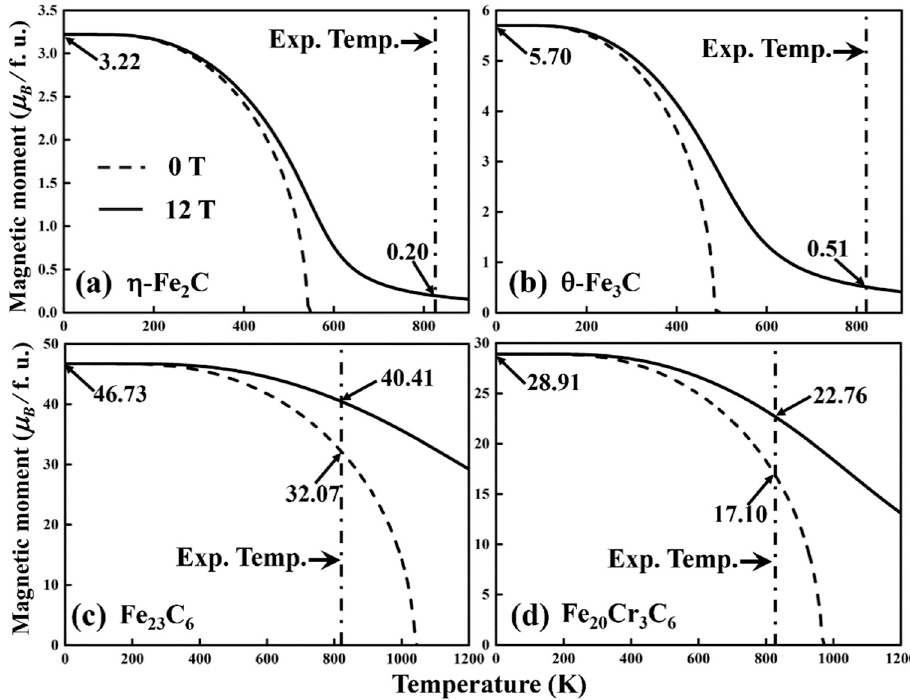
Figure 4. Magnetic moments of ( a ) η -Fe 2 C, ( b ) θ -Fe 3 C, ( c ) Fe 23 C 6 and ( d ) Fe 20 Cr 3 C 6 with (solid lines) or without a magnetic field (dash lines). The arrows indicate the magnetic moments determined by first-principle calculations (T = 0 K), the magnetic moments of carbides at 823 K (550 ◦ C) without a magnetic field (B = 0 T) and the magnetic moments at 823 K (550 ◦ C) with a magnetic field (B = 12 T), respectively.